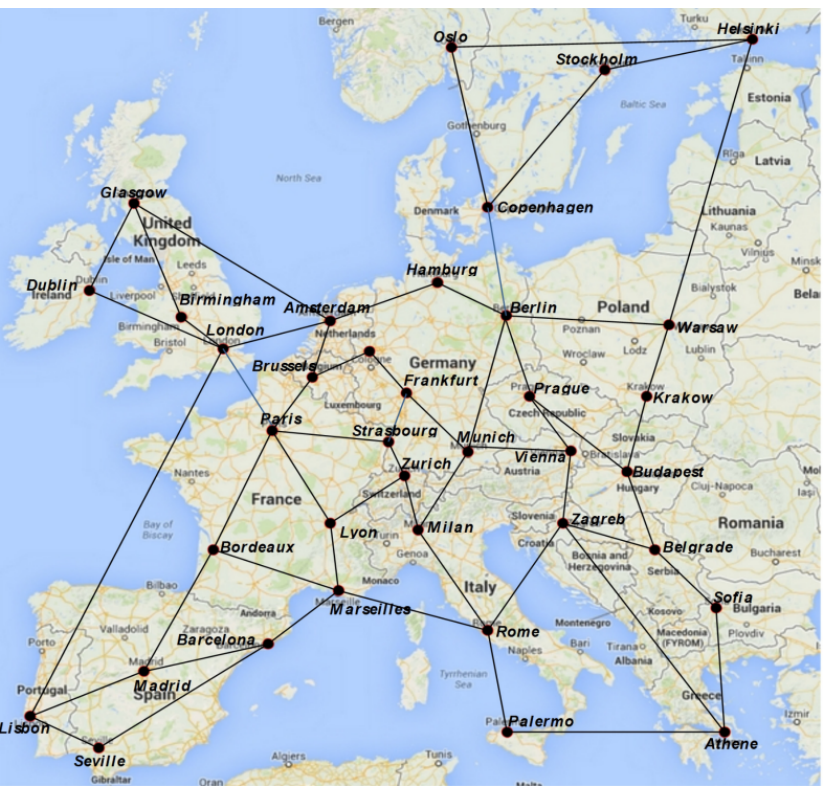
Figure 2. European Reference Network (ERnet). Copyright © IEEE. All rights reserved. Reprinted, with permission, from [32]. Table 2. Table of Discovered Paths in the First Example.